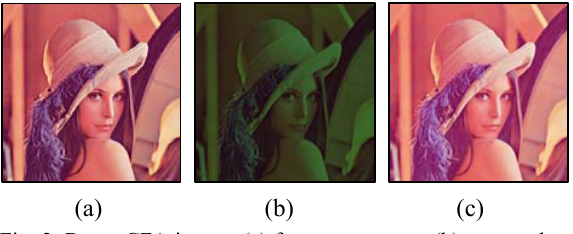
Fig. 2. Bayer CFA image: (a) from raw sensor, (b) arranged as a color domain, (c) recovered by interpolation from